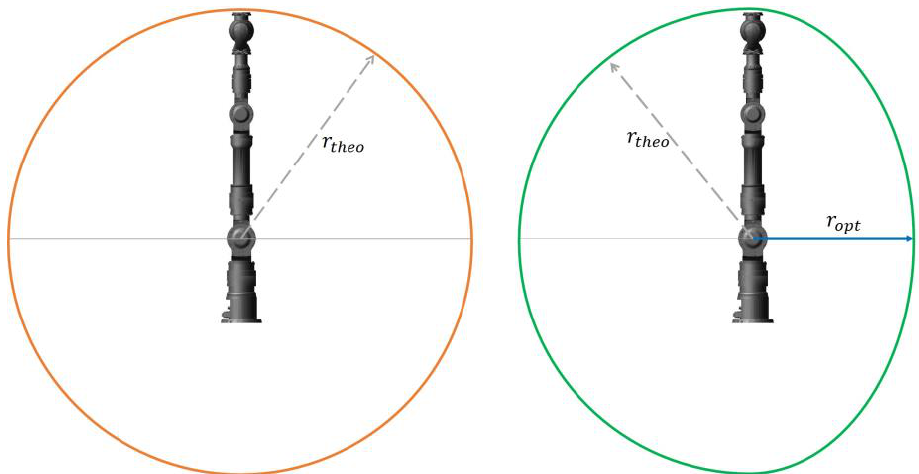
Figure 5. Theoretical ( a ) and noncritical workspace optimization ( b ).